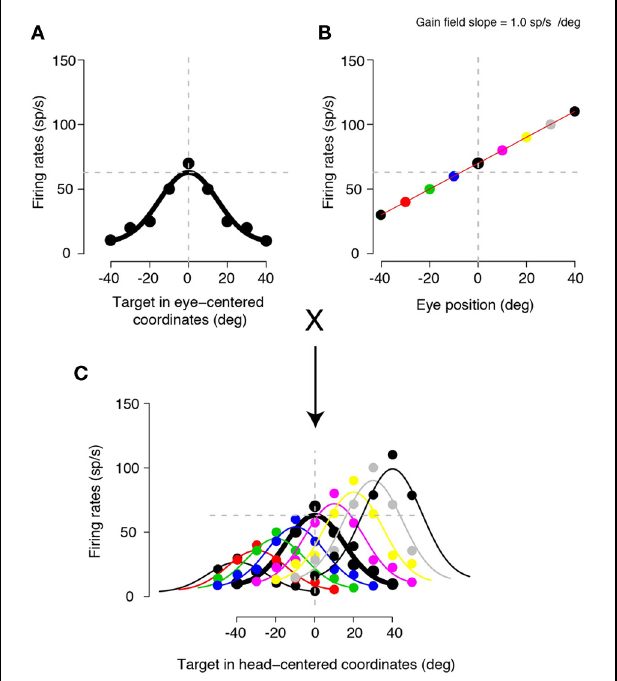
FIGURE 1 | A simulation of a gain field mediated coordinate transformation. (A) A neuron encoding target locations using an eye-centered frame of reference, when the eyes are straight ahead. (B) The same neuron showing an eye position gain field. The responses are shown for a target straight ahead of and aligned with the eyes. The responses are monotonically scaled by changes in eye position (eyes-on-head). For this particular example neuron, the activity increases by 1.0 spikes/sec (sp/s) for each visual degree of rightward change in eye position. Different colored points represent different eye positions. (C) Multiplying the eye-centered tuning curve with different eye positions. Each colored curve represents a tuning curve obtained by multiplying the eye-centered tuning from (A) with each eye position from (B) (in corresponding colors). When the eye position is at 0, that is, the same position as the plot in (A), the tuning does not change (indicated by the thick black traces in A and C ). However, when the eye positions change, the tuning curves now scale and shift according to the eye position gain field. These multiplicative interactions result in target representations that can be read out in a head-centered frame of reference; now the responses are tuned relative to the